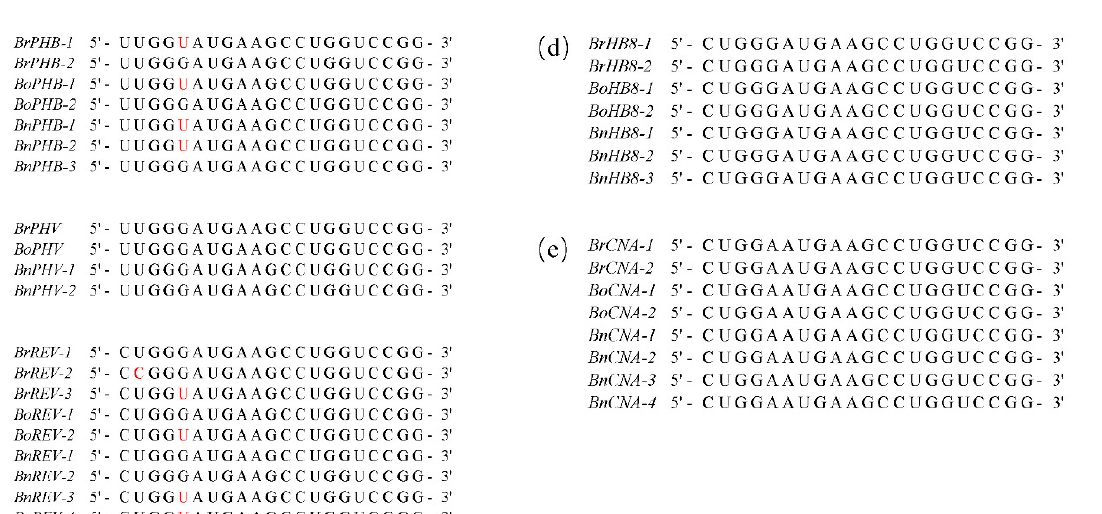
Figure 8. Validation of genetic variation in the BrREV genes targeted by miR165/166. ( a ) Alignment of the PCR sequencing results from B. rapa (Bre, HQ and ZCT) plants and the BrREV reference genes. ( b ) Sequencing signal of BrREV -2 at the miR165/166 target area in the B. rapa (HQ) plant. ( c ) Sequencing signal of BrREV -3 at the miR165/166 target area in the B. rapa (HQ) plant. Red arrows indicate the polymorphisms that differed from other BrREV and AtREV genes.